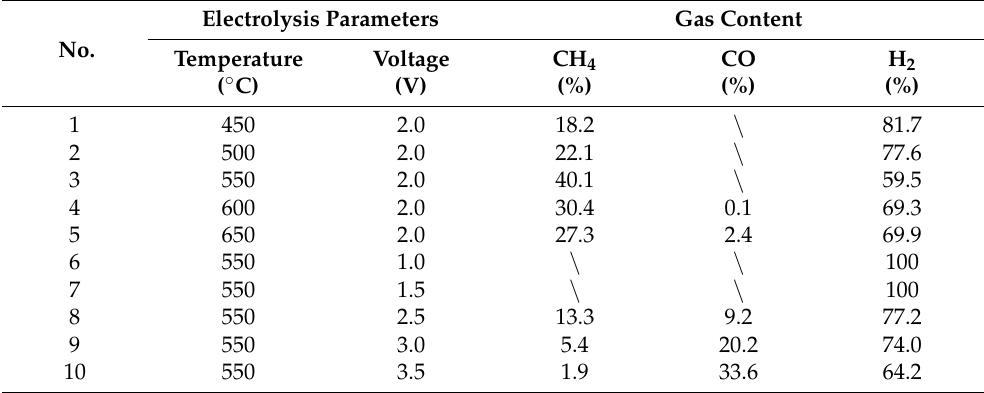
Table 2. The results of the gaseous products in Li 1.43 Na 0.26 K 0.21 CO 3 + LiOH (90%: 10%, wt%) under different